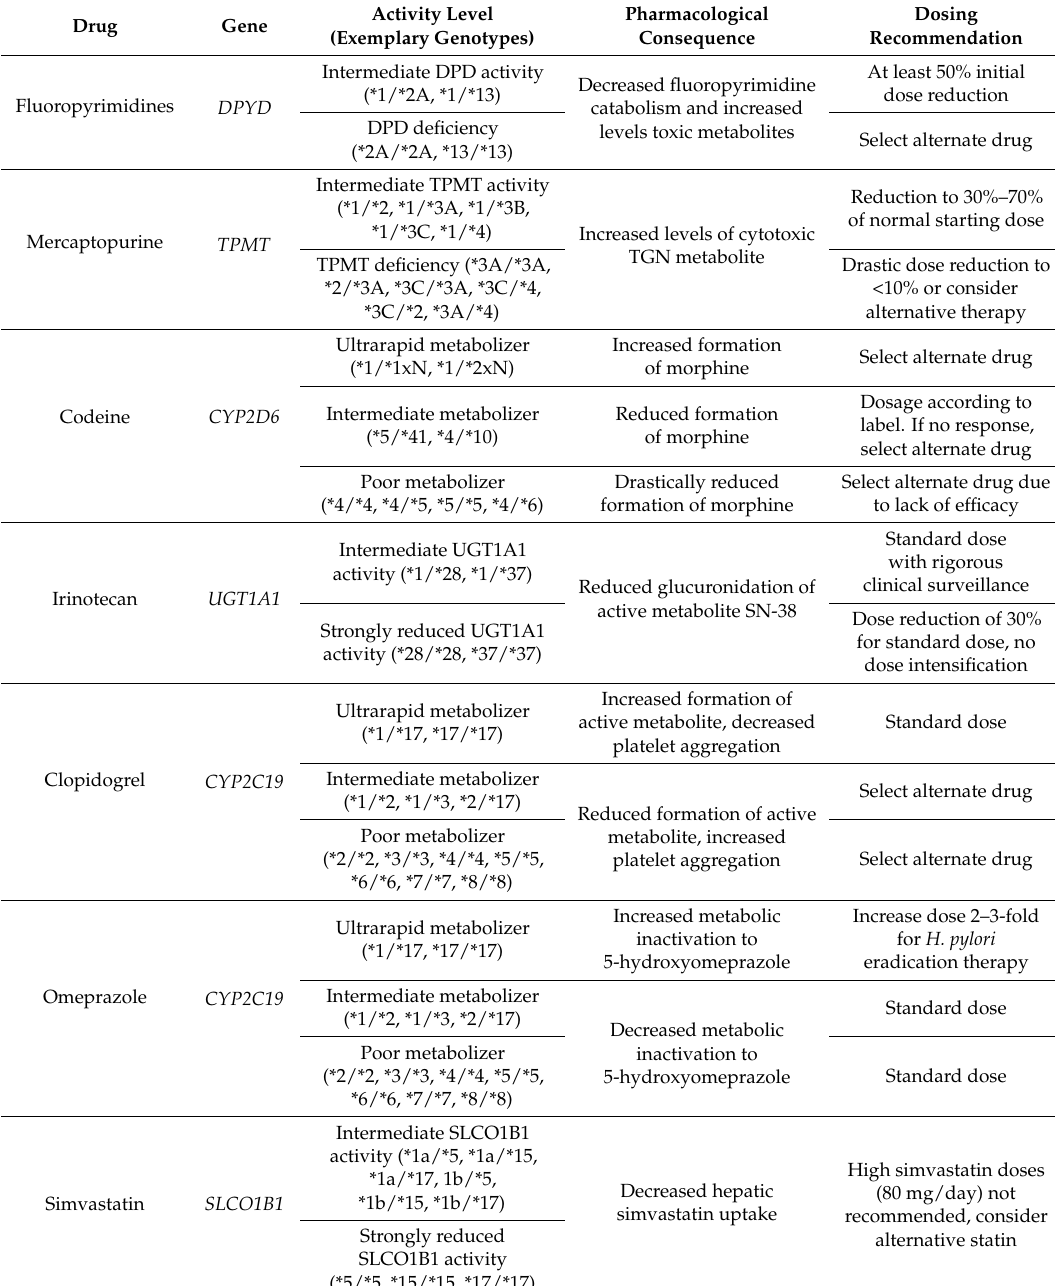
Table 2. Pharmacogenetic associations and their impact on dosing and prescribing. Dosing recommendations were gathered from the Clinical Pharmacogenetics Implementation Consortium (CPIC), the Royal Dutch Association for the Advancement of Pharmacy—Pharmacogenetics Working Group (DPWG) and the French National Pharmacogenetics Network together with the Group of Clinical Onco-pharmacology. DPD = dihydropyrimidine dehydrogenase; TPMT = thiopurine S